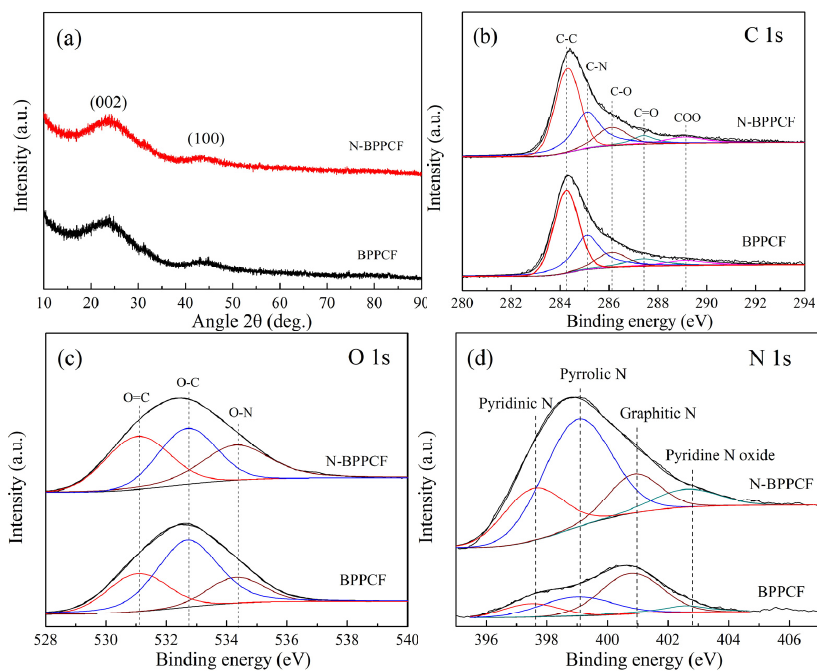
Figure 4. ( a ) X-ray diffraction (XRD) patterns for BPPCF and N-BPPCF samples. X-ray photoelectron Table 2. Element composition by XPS of the BPPCF and N-BPPCF samples.